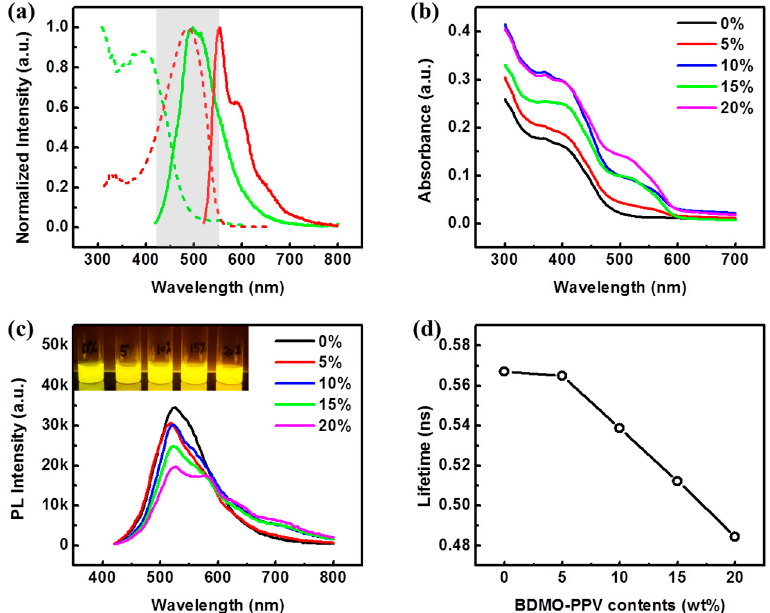
Figure 3. ( a ) Normalized absorption (dash line) and fluorescence (solid line) spectra of PFV (green) and BDMO-PPV (red) solutions; ( b ) Absorption spectra of Pdots doped with different BDMO-PPV contents; ( c ) Fluorescence spectra of Pdots doped with different BDMO-PPV contents (The inset photo shows the corresponding colors under a 365 nm UV lamp); ( d ) Average lifetimes of Pdots doped with various BDMO-PPV contents.